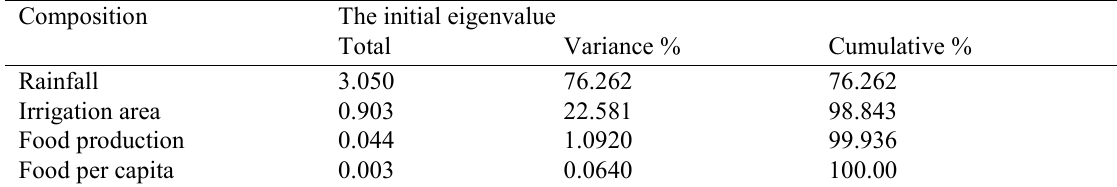
Table 2 The characteristic value and contribution of the